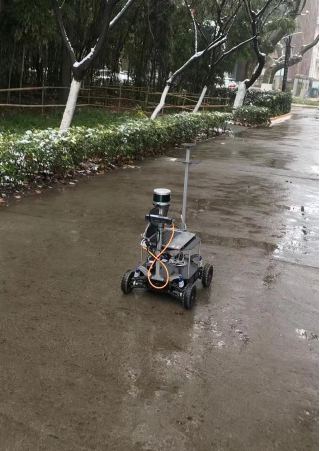
Figure 3. Mobile robot